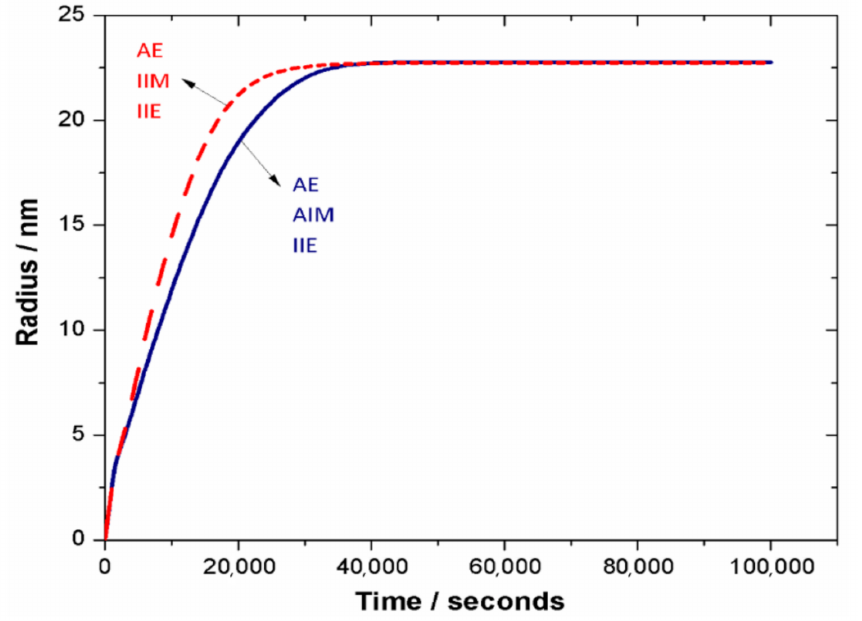
Figure 5. Phase-field simulated equivalent average radius of a single θ (cid:48) precipitate vs. time in Al-1.69 at.% Cu alloy annealed at 453